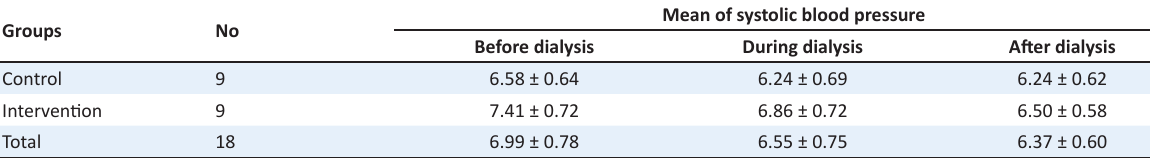
Table 2. Effect of sertraline on diastolic blood pressure before, during and after dialysis